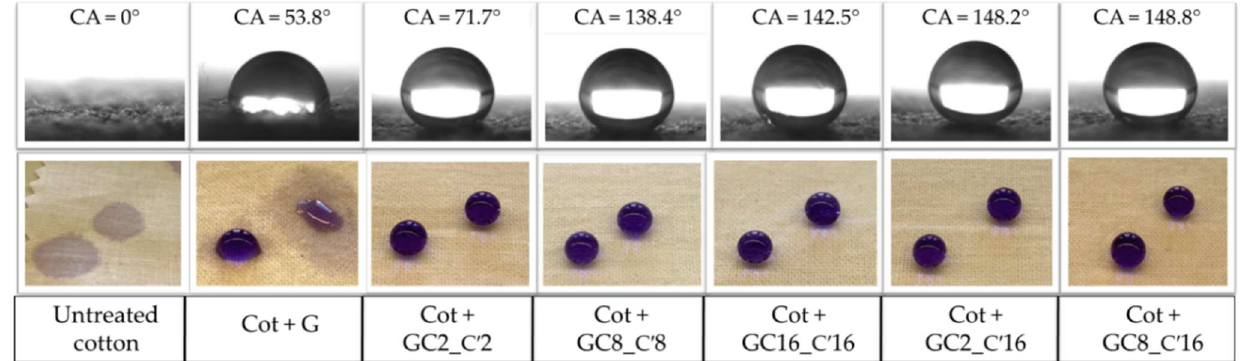
Figure 9. The images show the change in water contact angle and colored water droplets sitting on coated cotton fabrics and untreated cotton.